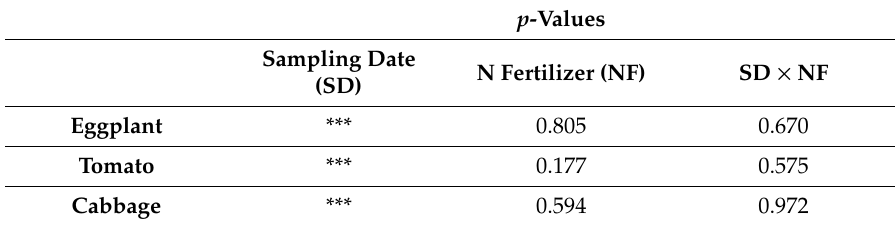
Table 1. Results of the two-factorial ANOVA testing the e ff ect of sampling date (SD) and fertilizer (NF) on the measured biomass of eggplant, tomato, and